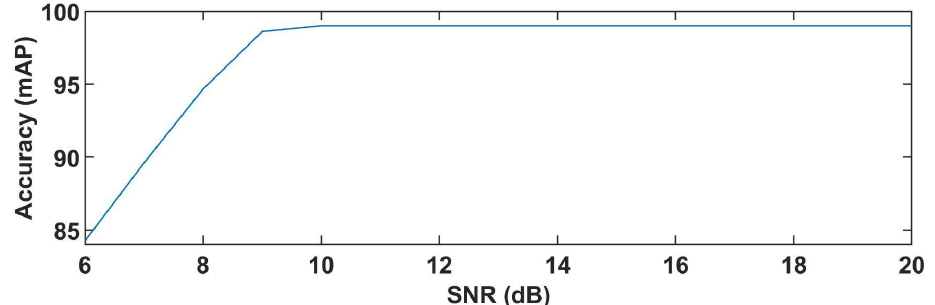
Figure 12. Fringe detection accuracy provided by the DNNs as a function of SNR of simulated noisy SMI signals. C for these SMI signals varies in the range from 0.4 to